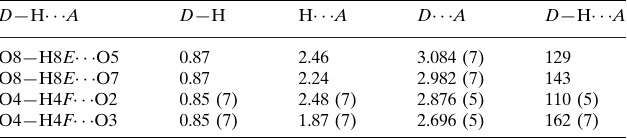
Hydrogen-bond geometry (A˚ , (cid:3)